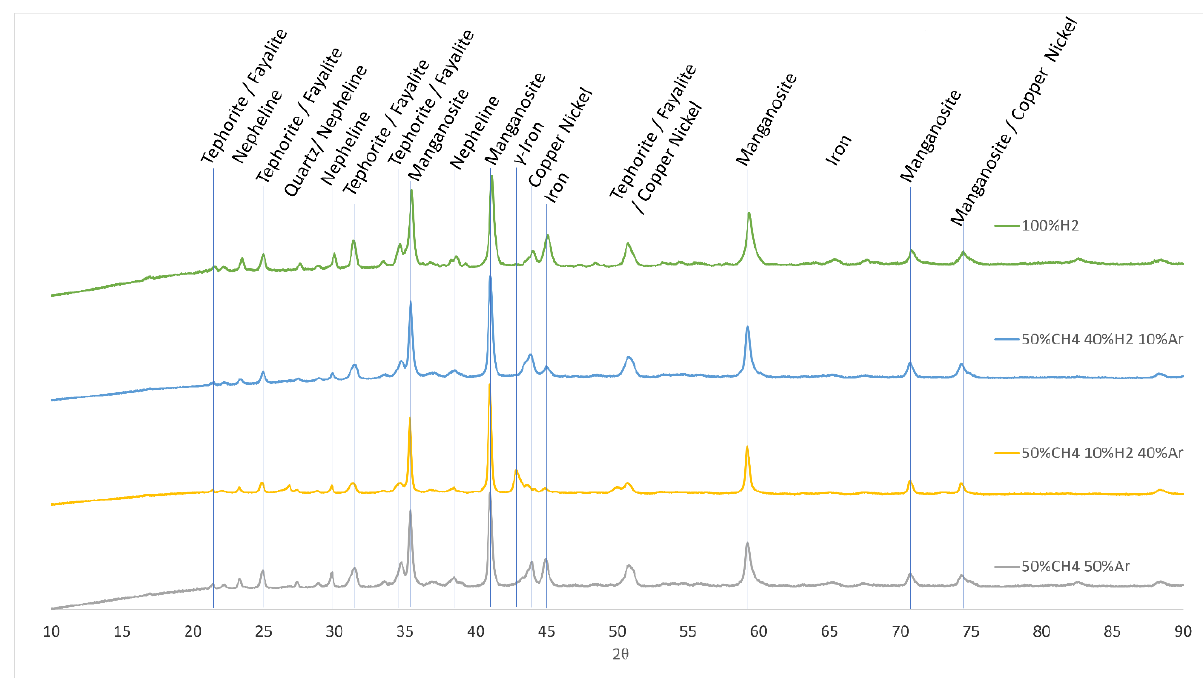
Figure 8. The stacked XRD patterns of PMMN samples reduced by different gases with their identified peaks.